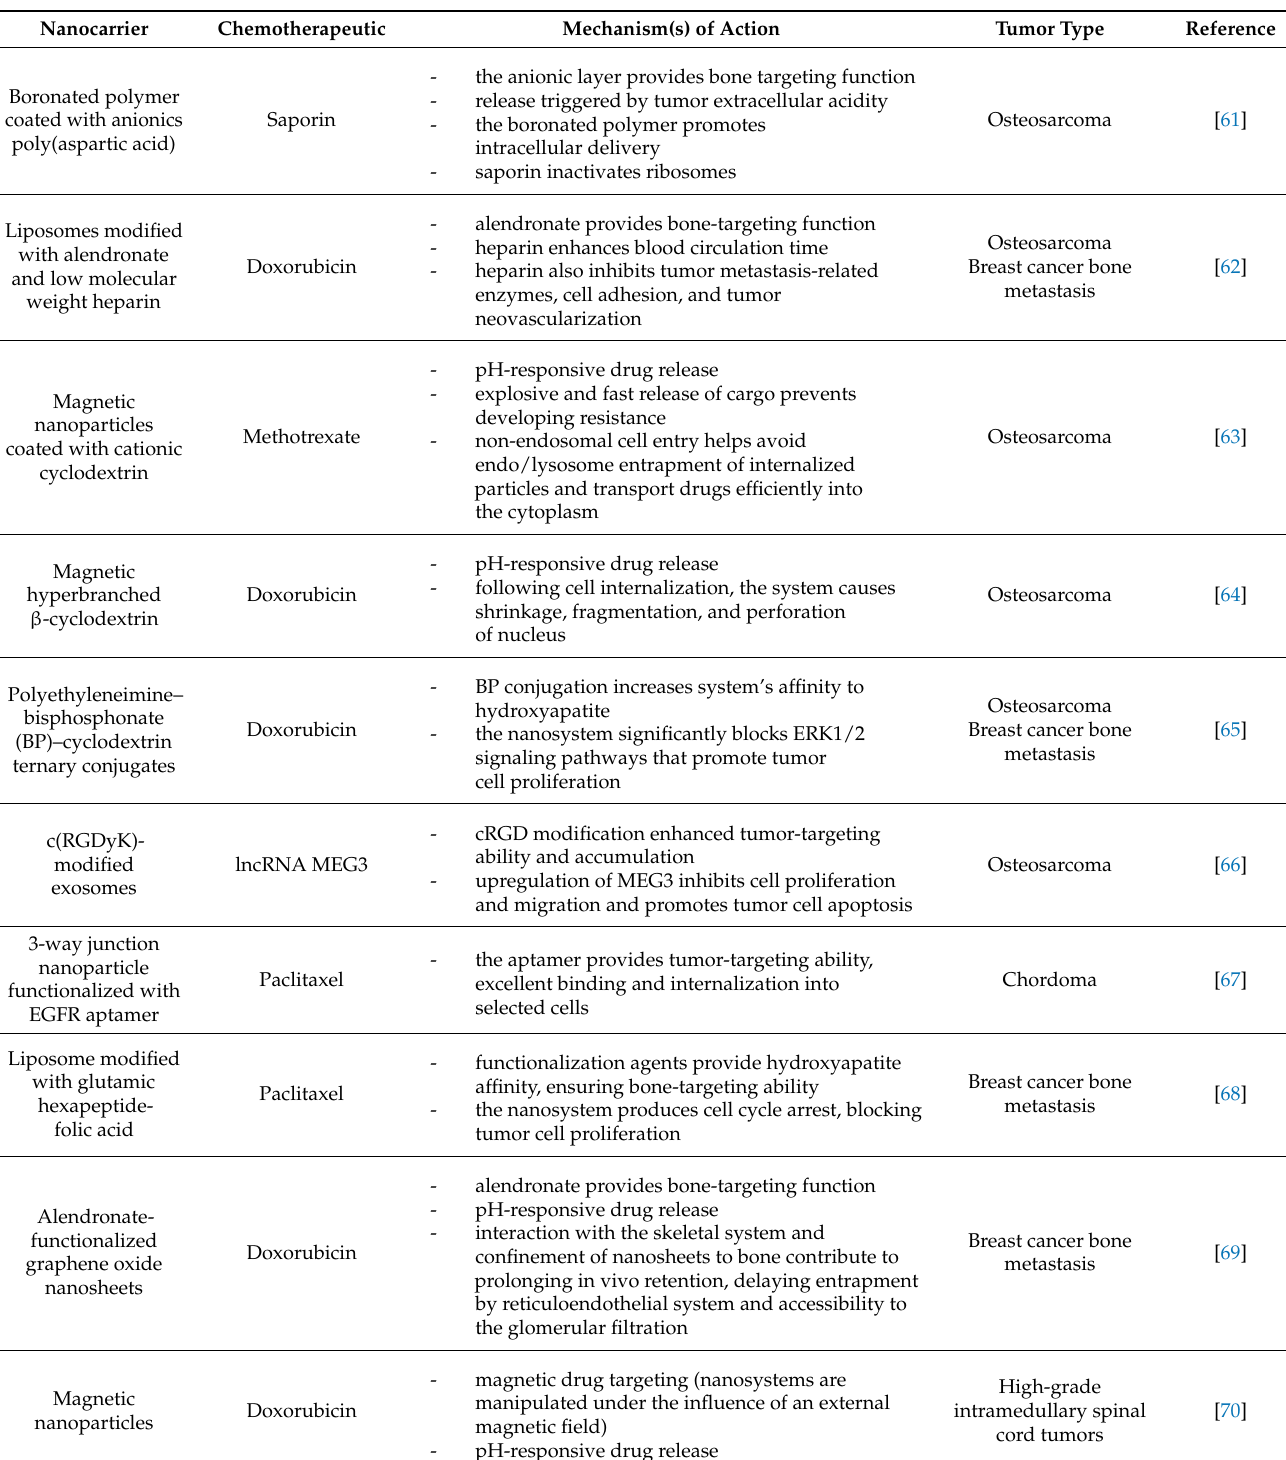
Table 1. Summary of discussed tumor-targeting